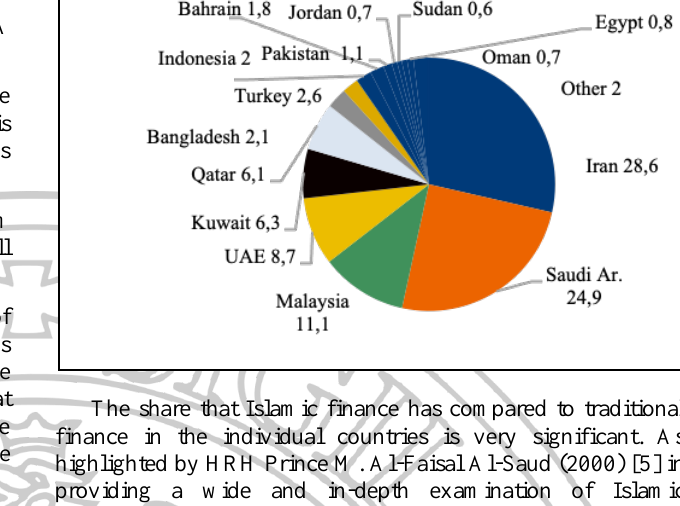
Figure 1. Islamic Finance (breakdown of TA between geographical areas, 2019). Note: MESA includes Afghanistan, Bangladesh, Iran, Iraq, Jordan, Lebanon, the Maldives, Palestine, Pakistan and Sri Lanka. Source: our calculations based on IFSB figures.